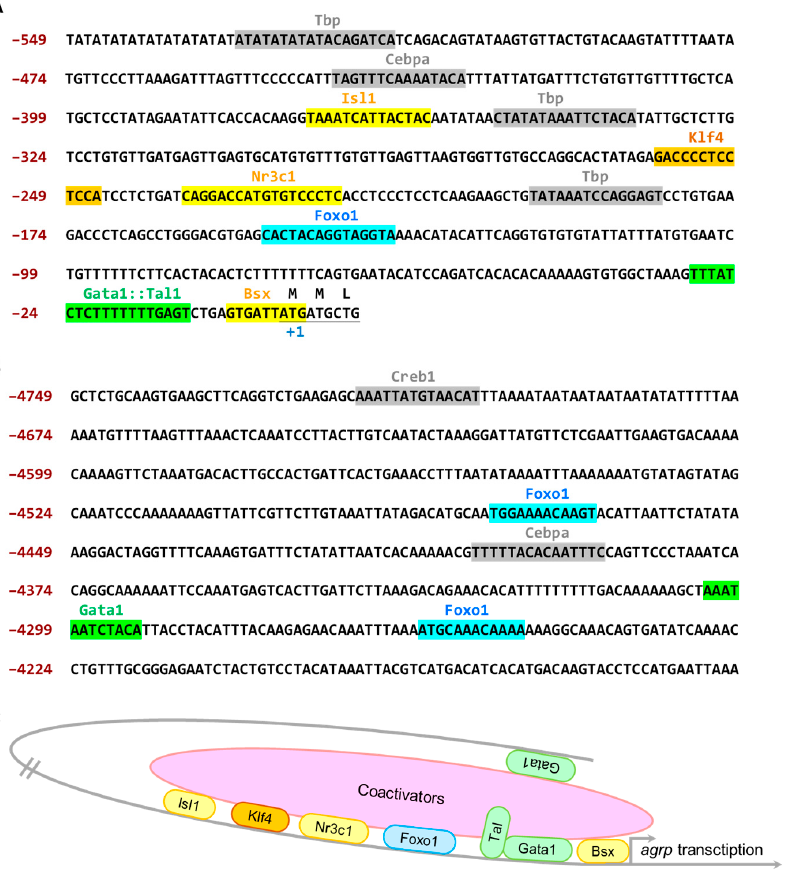
Figure 3. The sequence and potential response elements in the 4.7 kb agrp promoter of zebrafish. The nucleotide sequence was downloaded from the Ensembl website “https://asia.ensembl.org/Danio_rerio/Info/Index” (accessed on 2 May 2022). ( A ) The translational start codon (ATG) is underlined and shown as position +1. Nucleotides are numbered on the right, starting with the translational codon. Potential binding motifs in the proximal region are also marked. ( B ) Sequences of the putative agrp regulatory element. The predicted binding motif within a distal region of agrp promoter. Potential binding motifs are marked. ( C ) Hypothetical model of agrp transcription activation in zebrafish. The proteins shown in the figure are: TATA-box-binding protein (Tbp), CCAAT/enhancer-binding protein alpha (Cebp α ), ISL LIM homeobox 1 (Isl1), Kruppel-like factor 4 (Klf4), nuclear receptor subfamily 3 group C member 1 (Nr3c1), forkhead box O1 (Foxo1), GATA-binding protein 1 (Gata1), T cell acute lymphocytic leukemia 1 (Tal1), and brain-specific homeobox